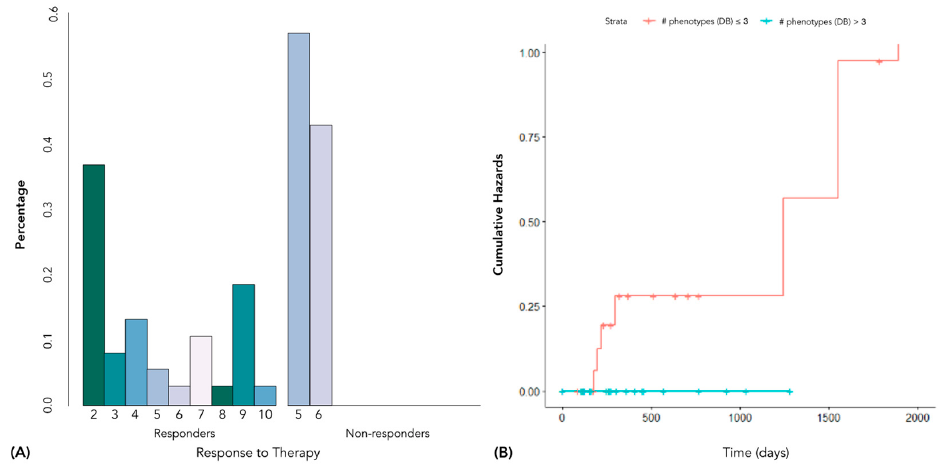
Figure 7. Best cutoff value for Davies–Bouldin-based number of phenotypes to discriminate between responder and not responder patients: ( A ) barplot of patient proportion; ( B ) stratified Kaplan–Meier.